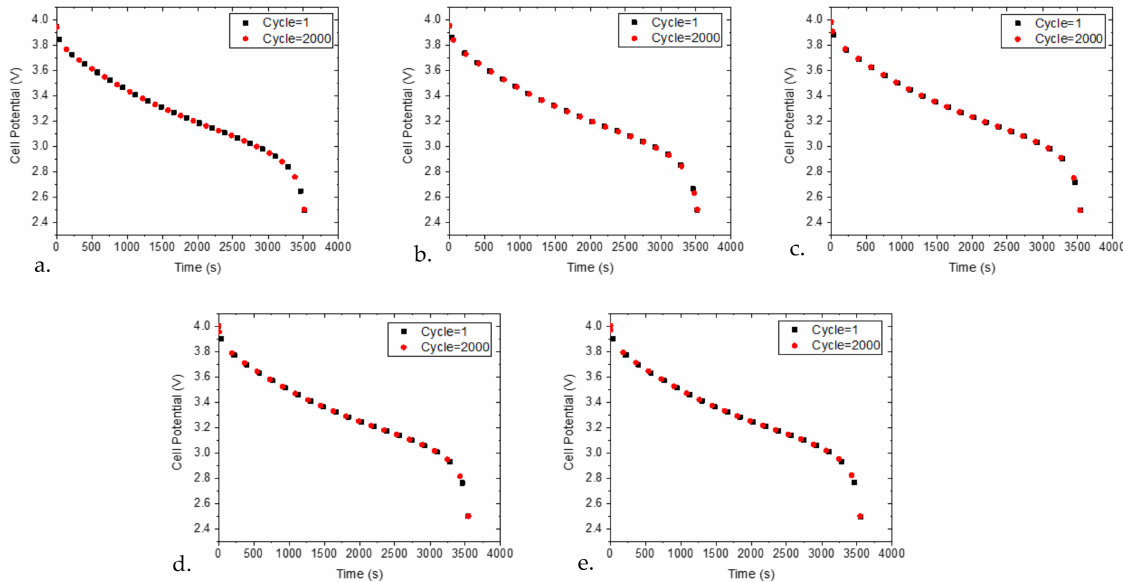
Figure 6. Simulated Discharge curves comparing NMC cathodes for the first and 2000th cycle when the negative electrode